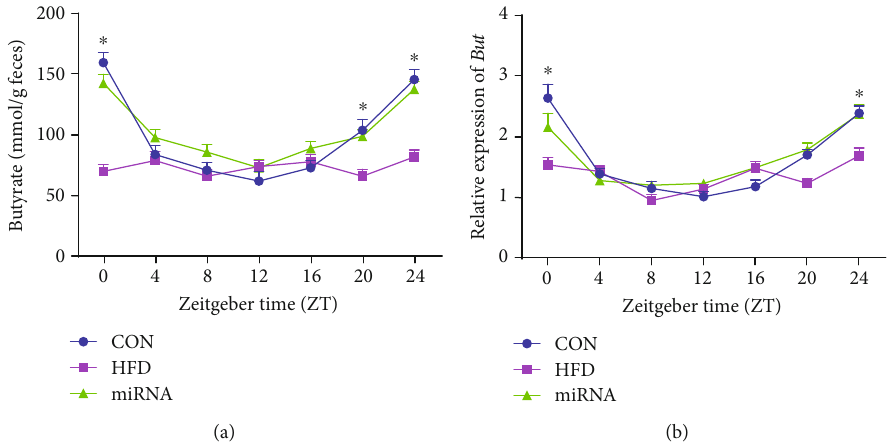
Figure 4: E ff ects of miRNA-10a-5p on diurnal rhythms of butyrate content and gene expression of But in high-fat diet-fed mice. (a) Relative abundance of Butyrate in feces; (b) relative expression of But . Data were expressed as Mean ± SEM . ∗ P < 0 : 05